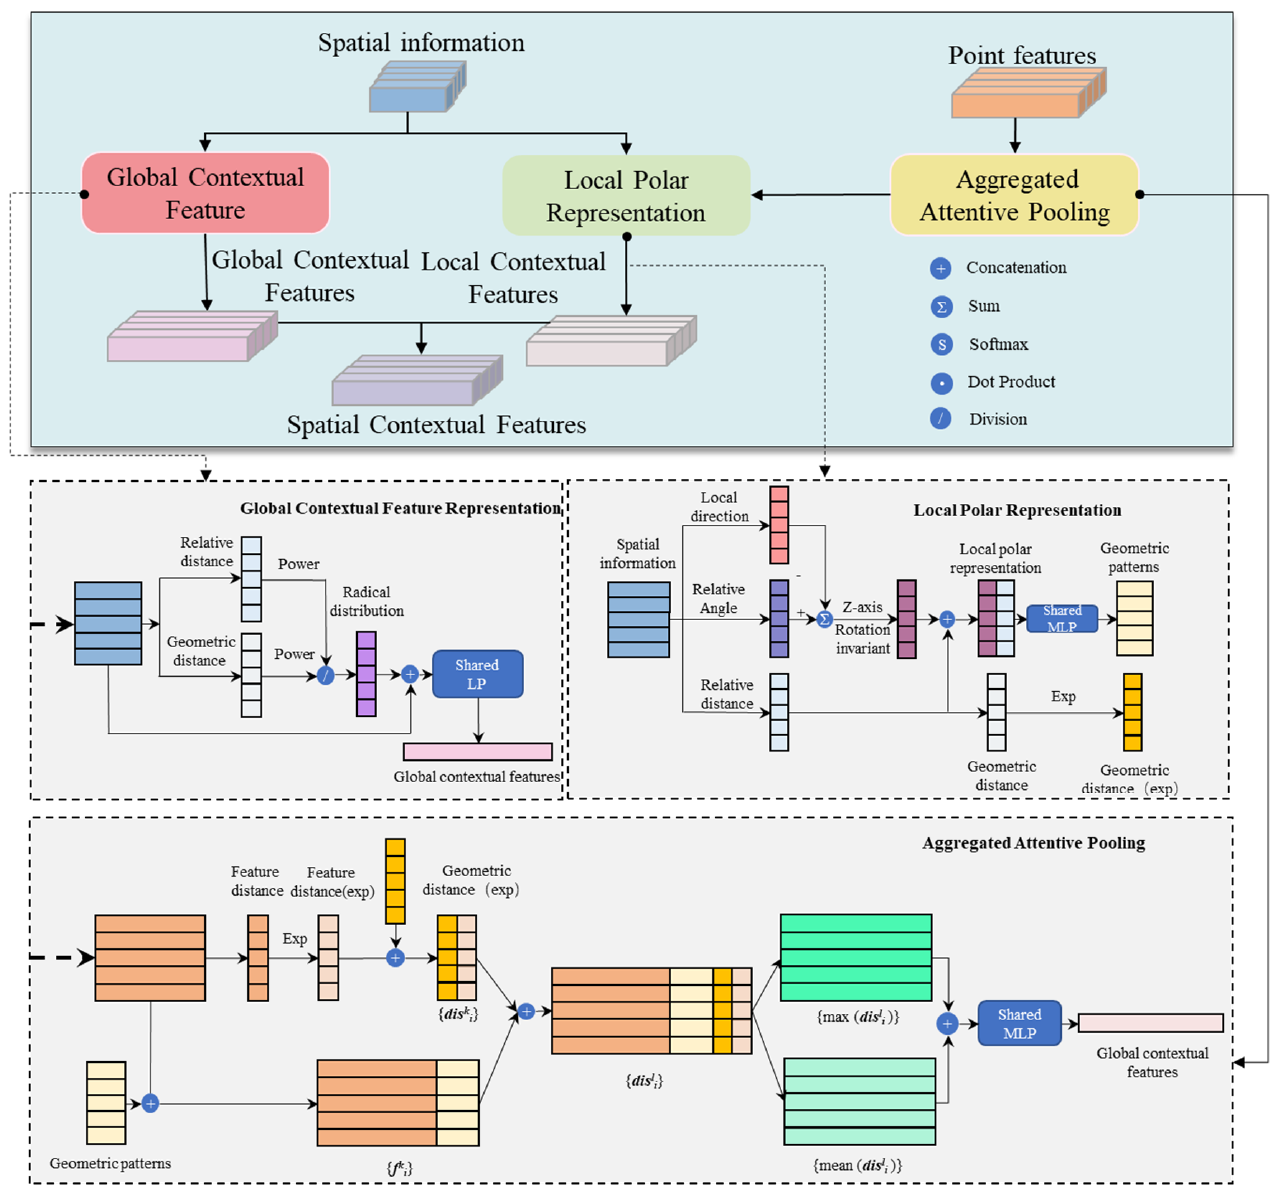
Figure 2. Improved SCF module.